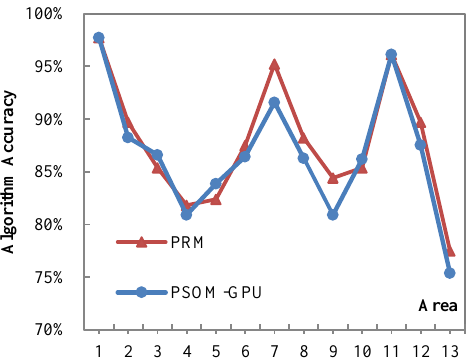
ISPRS Int. J. Geo-Inf. 2018 , 7 , x FOR PEER REVIEW Figure 7. Algorithm accuracy P of PRM and PSOM-GPU in thirteen areas (Areas 1–13). Figure 7. Algorithm accuracy P of PRM and PSOM-GPU in thirteen areas (Areas 1 – 13).